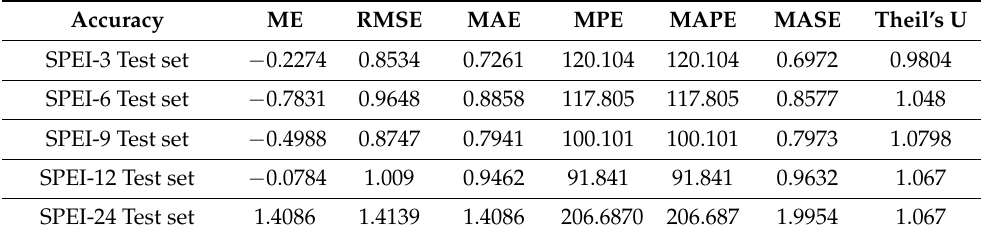
Table 14. Errors of SPEI-3, 6, 9, 12 and